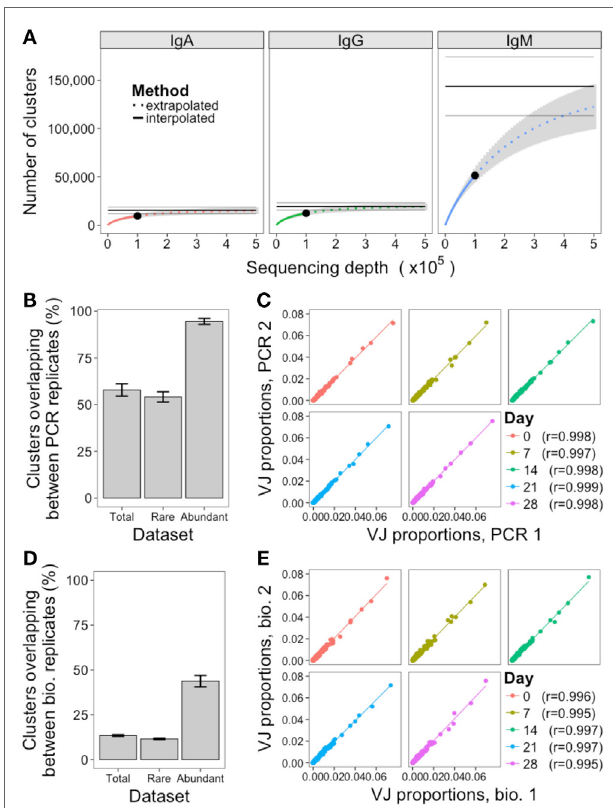
FigUre 3 | assessment of sequencing and sampling depth . (a) Extrapolated rarefaction curves for clusters of each isotype. Rarefaction analysis (interpolated) was conducted by subsampling data without replacement at 1,000 sequence increments, and determining the number of clusters represented by these sequences. Cluster richness estimation of the sample (extrapolation) was based on Chao’s estimator formula, and conducted up to a sequencing depth of 500,000 sequences. The curve shows the number of clusters identified as a function of sampling depth – as the curves start to plateau it indicates that increased sampling depth will yield few additional clusters, and sampling depth is sufficient. Results were calculated from samples from all 10 participants, and mean ± SEM (gray curve) plotted. The three horizontal gray lines show the mean ± SEM for the Chao estimate of total clusters in the sample. (B) For the PCR replicates, the percent of clusters present in both replicates was determined, where percent = ( A ∩ B /min( A , B )) × 100. This was determined for total clusters, rare clusters ( < 10 sequences), and abundant clusters ( ≥ 10 sequences) for all 10 participants, and mean ± SEM values plotted. (c) Correlation in proportion of the total repertoire comprised by each VJ gene combination in the two PCR replicates at each day. Each point represents the proportional representation of a particular VJ combination in the repertoire. r -Values represent Pearson’s correlation coefficients. (D,e) Same as (B,c) , but comparing the biological